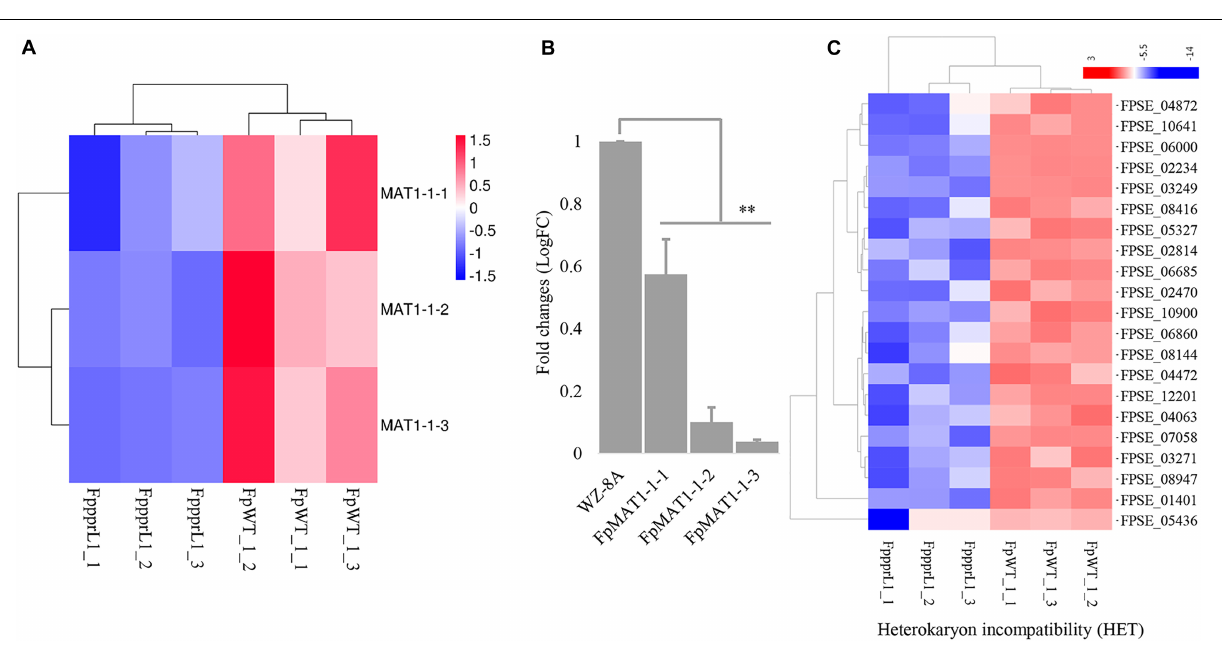
FIGURE 8 | The gene expression profiles on the mating type locus MAT1 and heterokaryon incompatibility. (A) Heatmap of the MAT1-1 idiomorphs MAT1-1-1 , MAT1-1-2 , and MAT1-1-3 with reduced expression levels in (cid:49) Fpppr1 mutant, data derived from RNA-seq and qRT-PCR confirmed (B) . (C) Heatmap for genes encoding heterokaryon incompatibility proteins (HET) ( ∗∗ p <